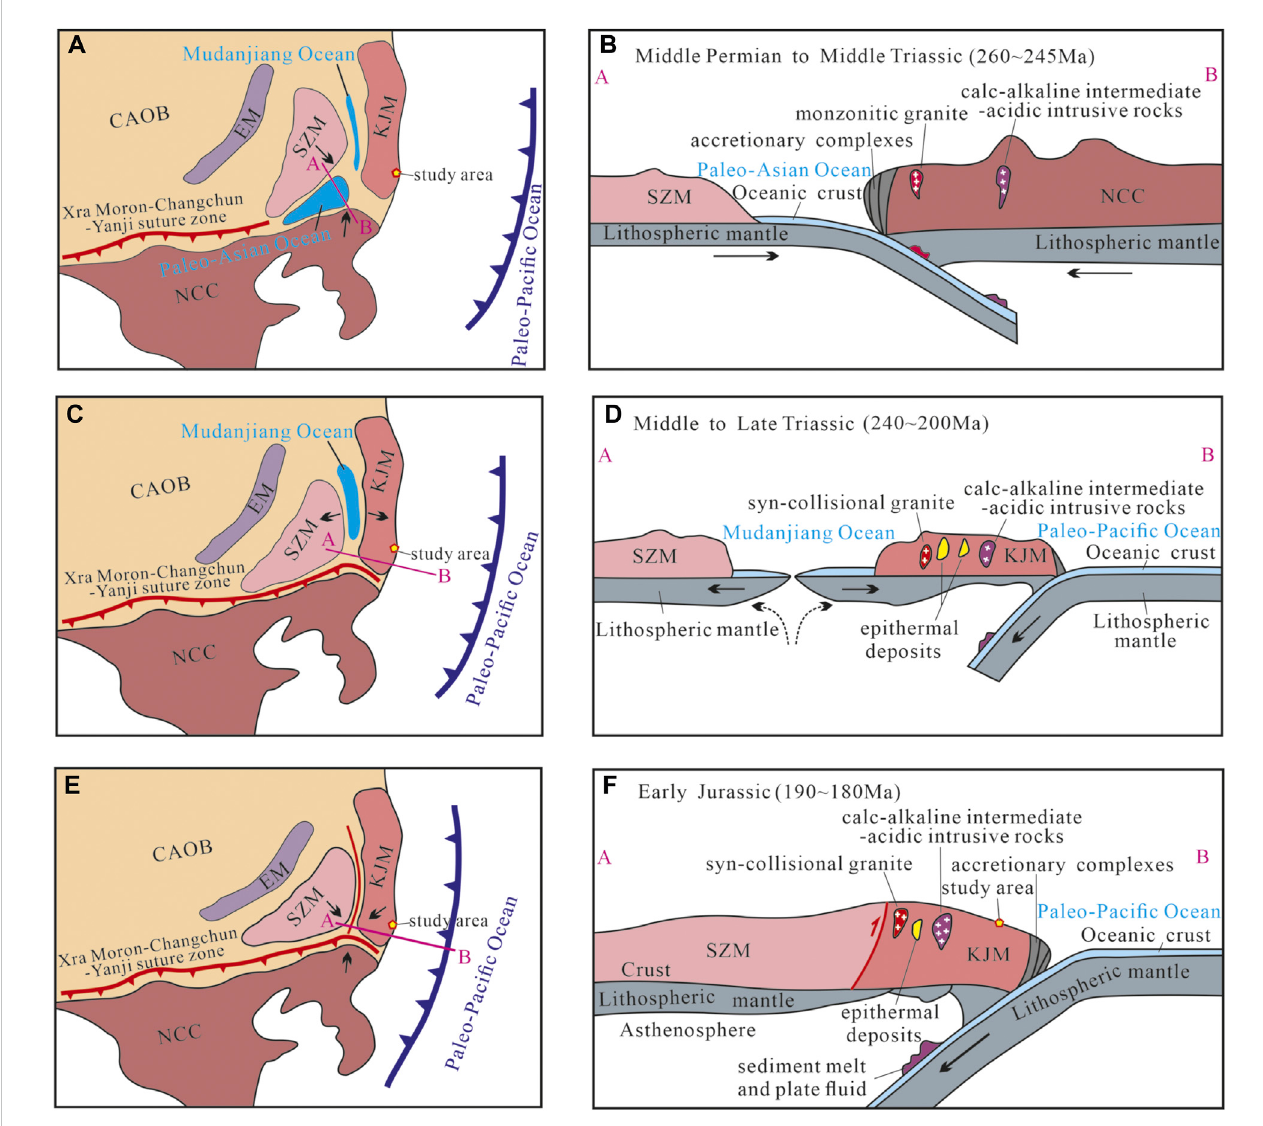
FIGURE 14 TectonicscenariosunderthePaleo-AsianOceanicregimeandthePaleo-Paci fi cregimeduringtheMiddlePermiantoEarlyJurassic(modi fi edfromYang et al., 2017; 2018;Long etal., 2020; Wei, 2021). The scissor-likeclosurebetweenthe Songnen-Zhangguangcai Range block and North China Plate during the Middle-PermiantoMiddle-Triassic (A,B) ;ThesubductionofthePaci fi cplatebeneaththeEurasianplatebeganinLateTriassic (C,D) ;TheclosureofMudanjiang Ocean, formation of Syn-collision S-type granites and calc-alkaline I-type granites happened in Early Jurassic (E,F)